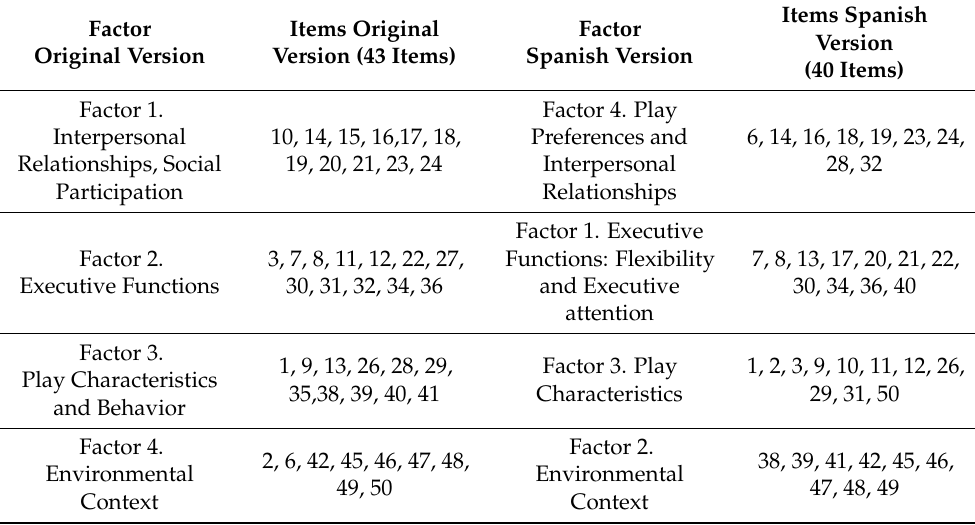
Table 4. Distribution of items for each factor in original and for Spanish version of My Children’s Play.